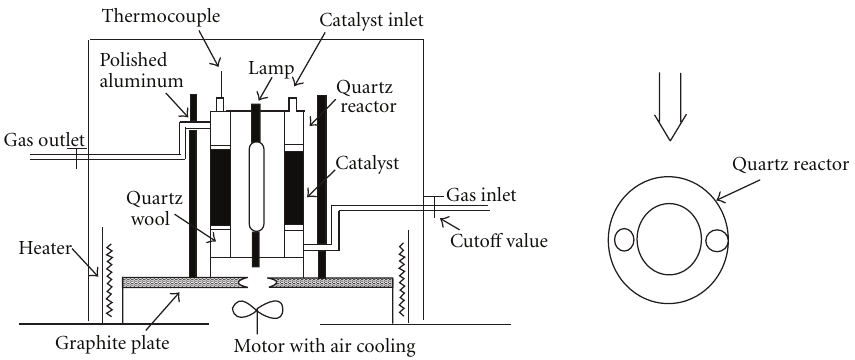
Figure 1: Reactor for photocatalytic H 2 evolution from glycerol